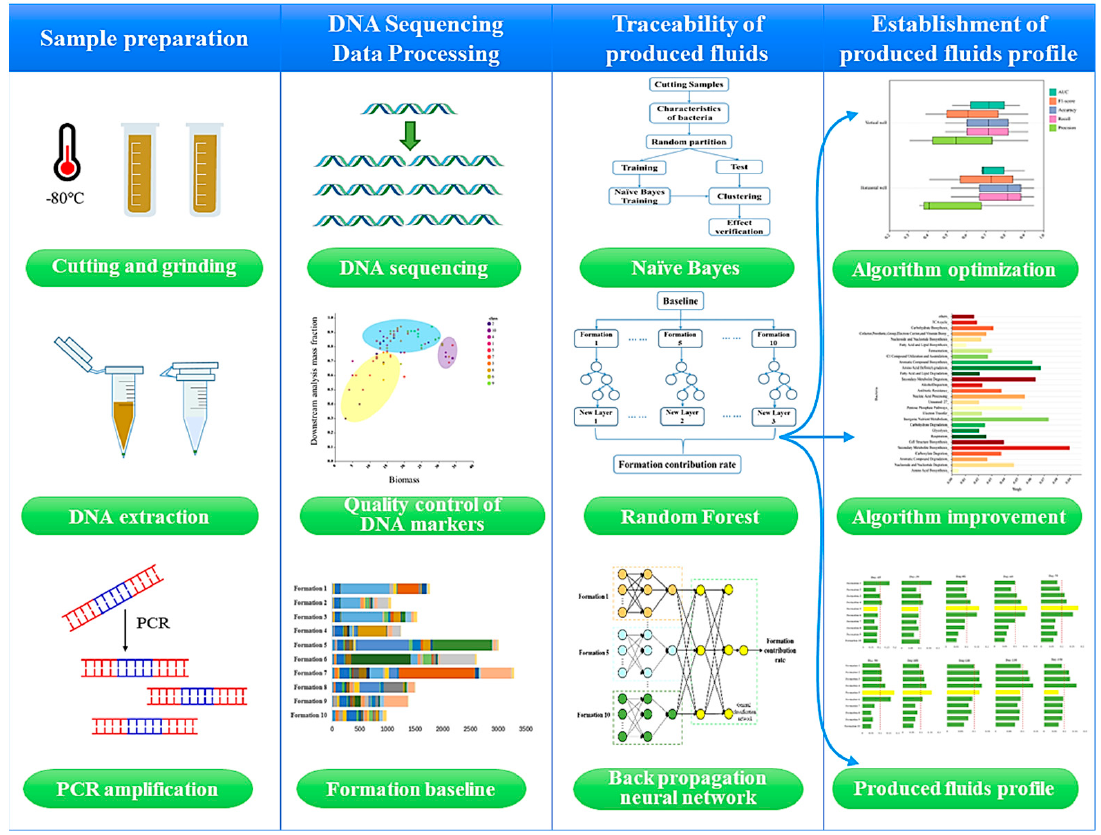
Figure 2. Produced fluids profile model based on microbial DNA sequencing.